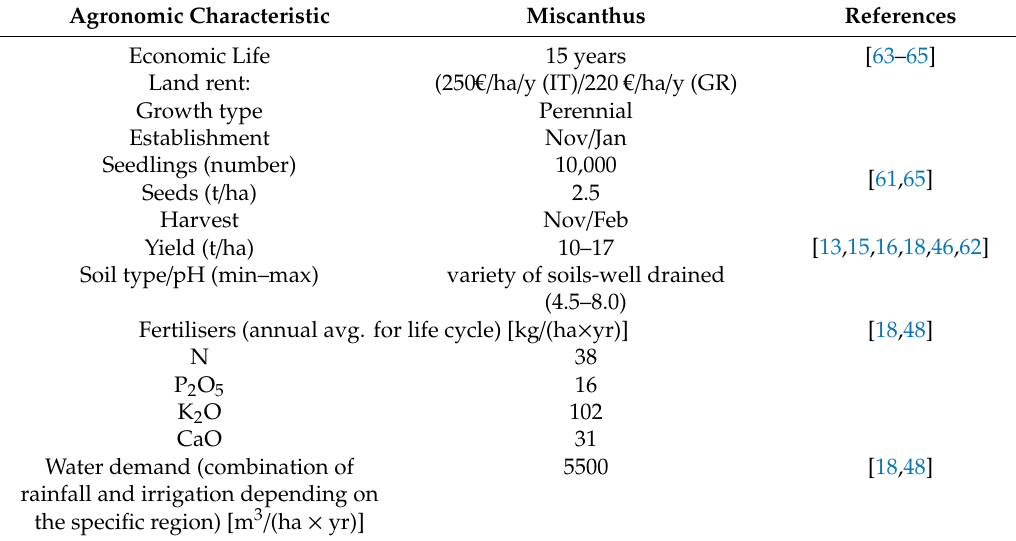
Table 4. Agronomic characteristics for